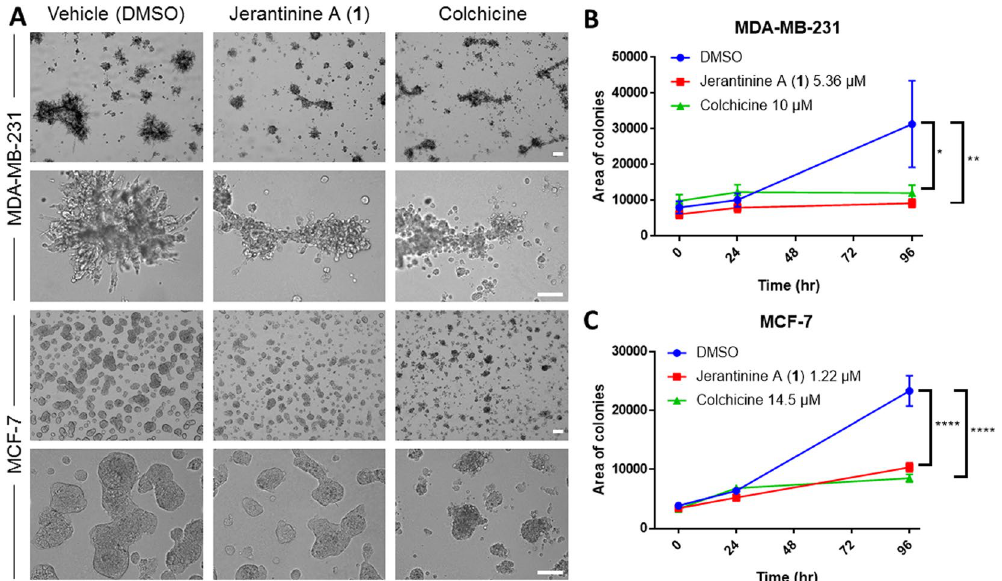
Figure 4. ( A ) MDA-MB-231 and MCF-7 breast cancer cells grown in 3D culture with vehicle (DMSO), jerantinine A ( 1 ) (5.36 µ M or 1.22 µ M‚ respectively) or colchicine (10 µ M or 14.5 µ M‚ respectively). Images from 96 h post agent exposure. Scale bar represents 200 µ m. ( B ) Quantification of the area of the MDA-MB-231 3D colonies over a 96 h period post agent addition. Mean ( ± S.E.M.) values are given. ( C ) Quantification of the area of the MCF-7 3D colonies over a 96 h period post agent addition. Mean ( ± S.E.M.) values are given. Data were generated from ≥ 2 separate trials; n = 2 per trial; * p < 0.05, ** p < 0.01, **** p <